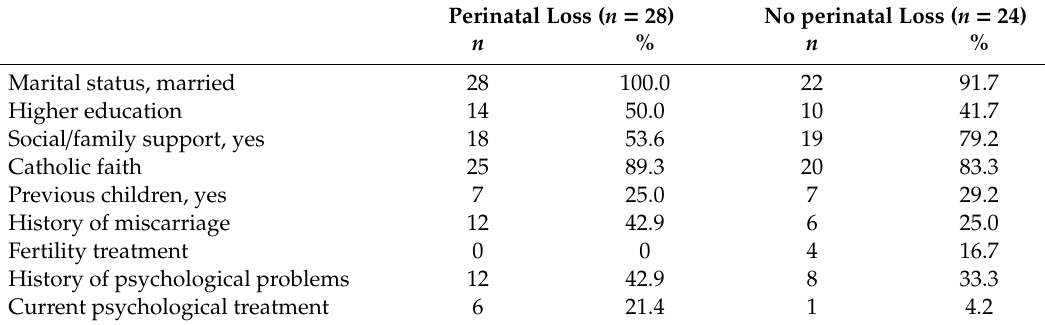
Table 1. Descriptive data for sociodemographic, clinical, and psychological variables according to whether perinatal loss occurred.